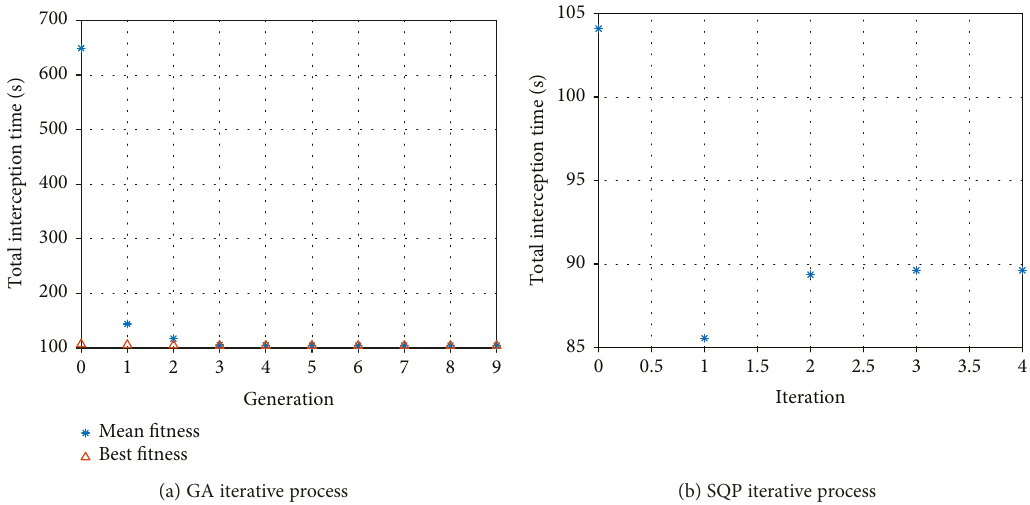
(b) SQP iterative process